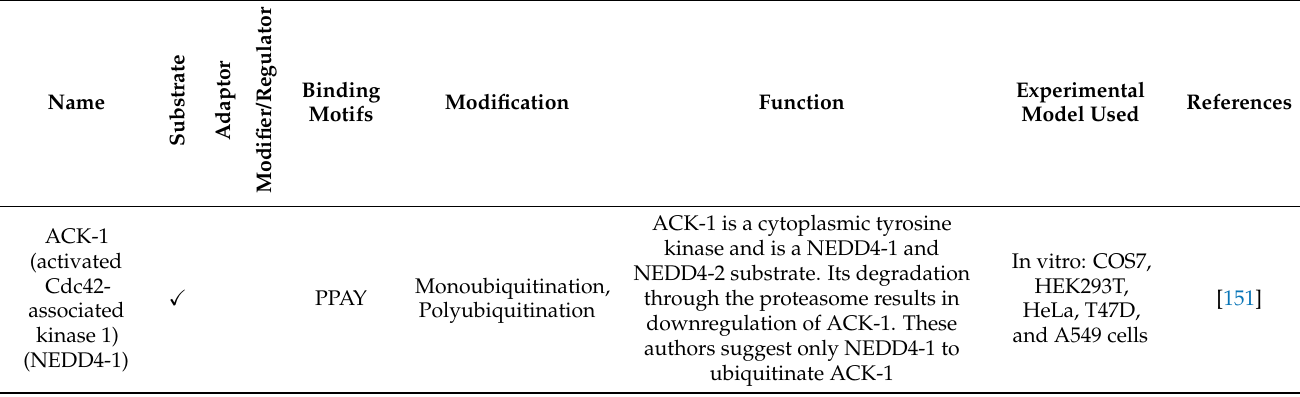
Table 3. Substrates, adaptors, and modifiers/regulators of both NEDD4-1 and